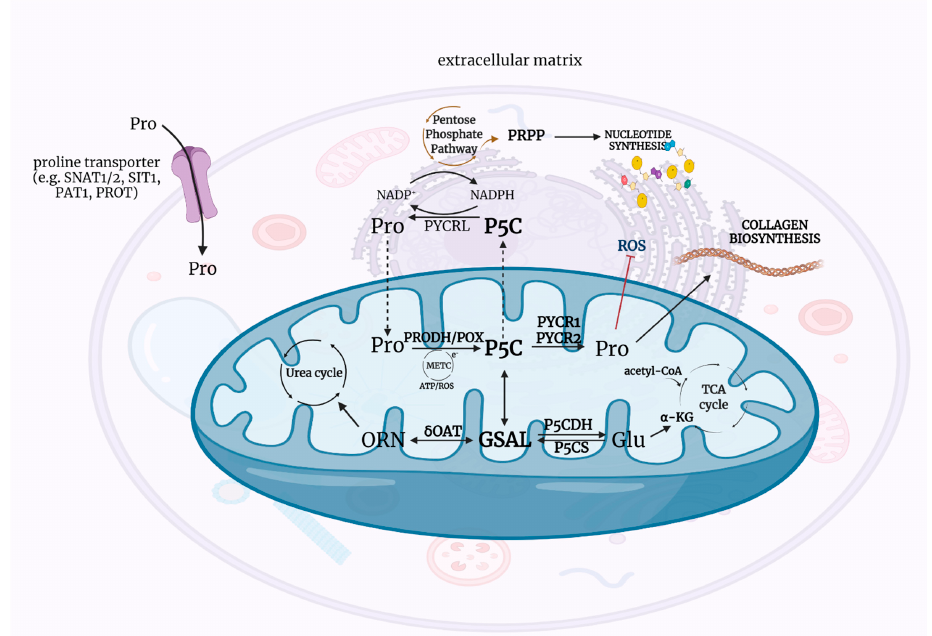
Figure 1. The metabolic pathways of P5C—physiological intracellular intermediate of the interconversion of proline, or- nithine, and glutamate. Acetyl-CoA—acetyl coenzyme A, ATP—adenosine triphosphate, α -KG— α -ketoglutarate, Glu—glutamate, GSAL—L-glutamate- γ -semialdehyde, METC—mitochondrial electron transport chain, NAD + —oxidized form of nicotinamide adenine dinucleotide, NADH—reduced form of nicotinamide adenine dinucleo- tide, NADP + –oxidized form of nicotinamide adenine dinucleotide phosphate, NADPH—reduced form of nicotinamide adenine dinucleotide phosphate, ORN—ornithine, P5C— Δ 1 -pyrroline-5-carboxylate, P5CDH—P5C dehydrogenase, P5CS—P5C synthase, PAT1—proton-coupled amino acid transporter 1, PRODH/POX—proline dehydrogenase/oxidase,